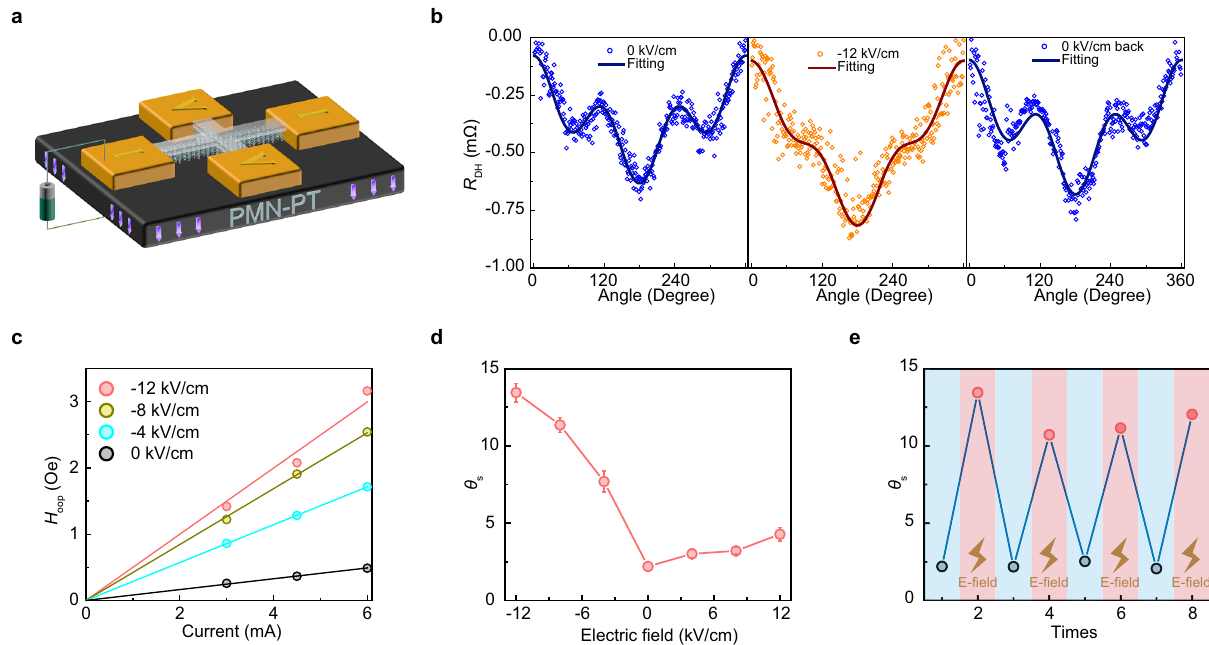
Fig. 3 In situ voltage controls spin Hall angle. a Schematics of the experimental setup for the voltage control spin Hall angle. b Typical angular-dependent R fi eld from 0 kV/cm to − 12 kV/cm, and then back to 0 kV/cm with the fi tting results. c The obtained effective fi eld H DH measured at the electric different electric fi elds with the linear fi tting results versus the applied current. d The spin Hall angle of Bi 2 Se 3 as a function of the external electric fi eld. Error bars represent standard deviation. e The reversibility test of the electric fi eld control process.